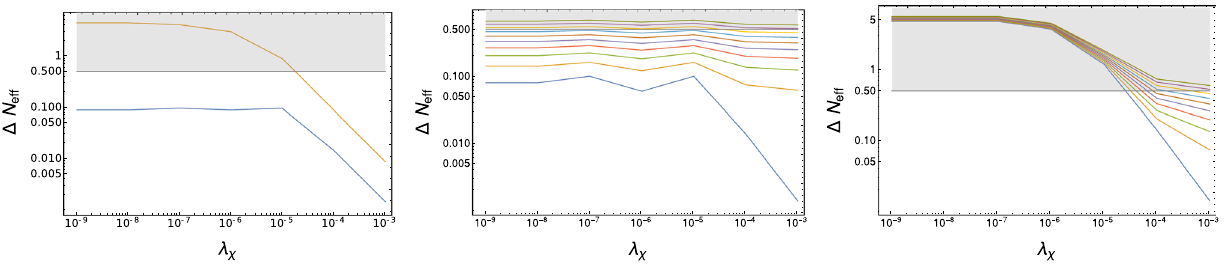
Fig. 5 (cid:12) N eff (taking contribution from both pseudoscalar and ster- ile neutrino) in Y-axis versus λ χ in X-axis, the left-most plot corre- sponds to the case when the inflaton decays only into the Higgs. The parameter values, namely, are m φ = 10 − 6 M Pl , λ φ = 10 − 14 , λ H = 10 − 4 , σ φ H = 10 − 8 M Pl , λ φχ = λ φ H = 10 − 7 , 10 − 6 from bottom to